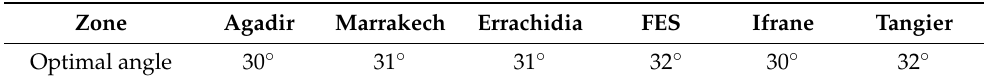
Table 1. Optimal tilt angle.